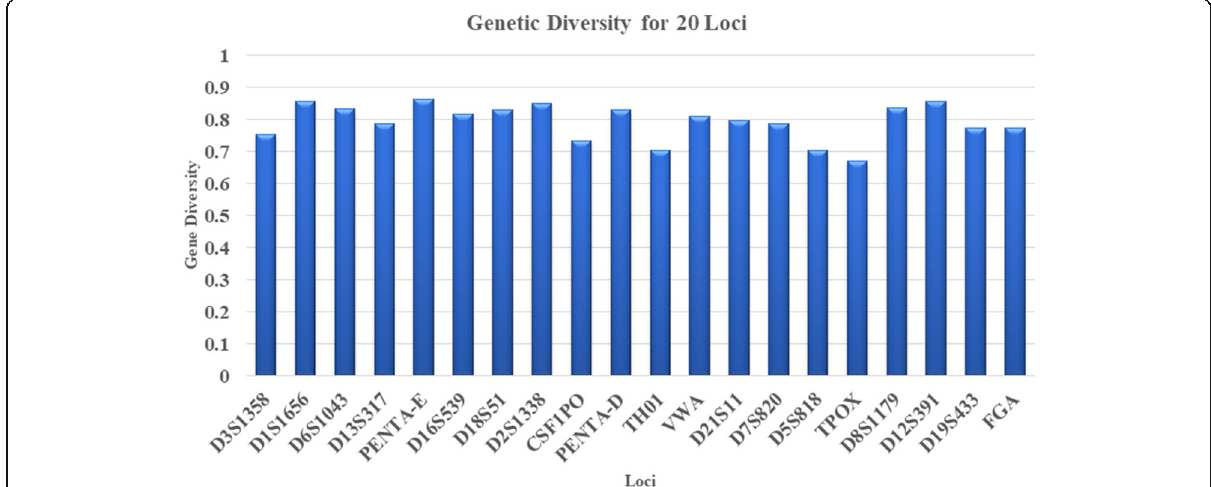
Fig. 1 Genetic diversity of Rabari Tribe of Gujarat population-based on 20 autosomal STRs ( n =